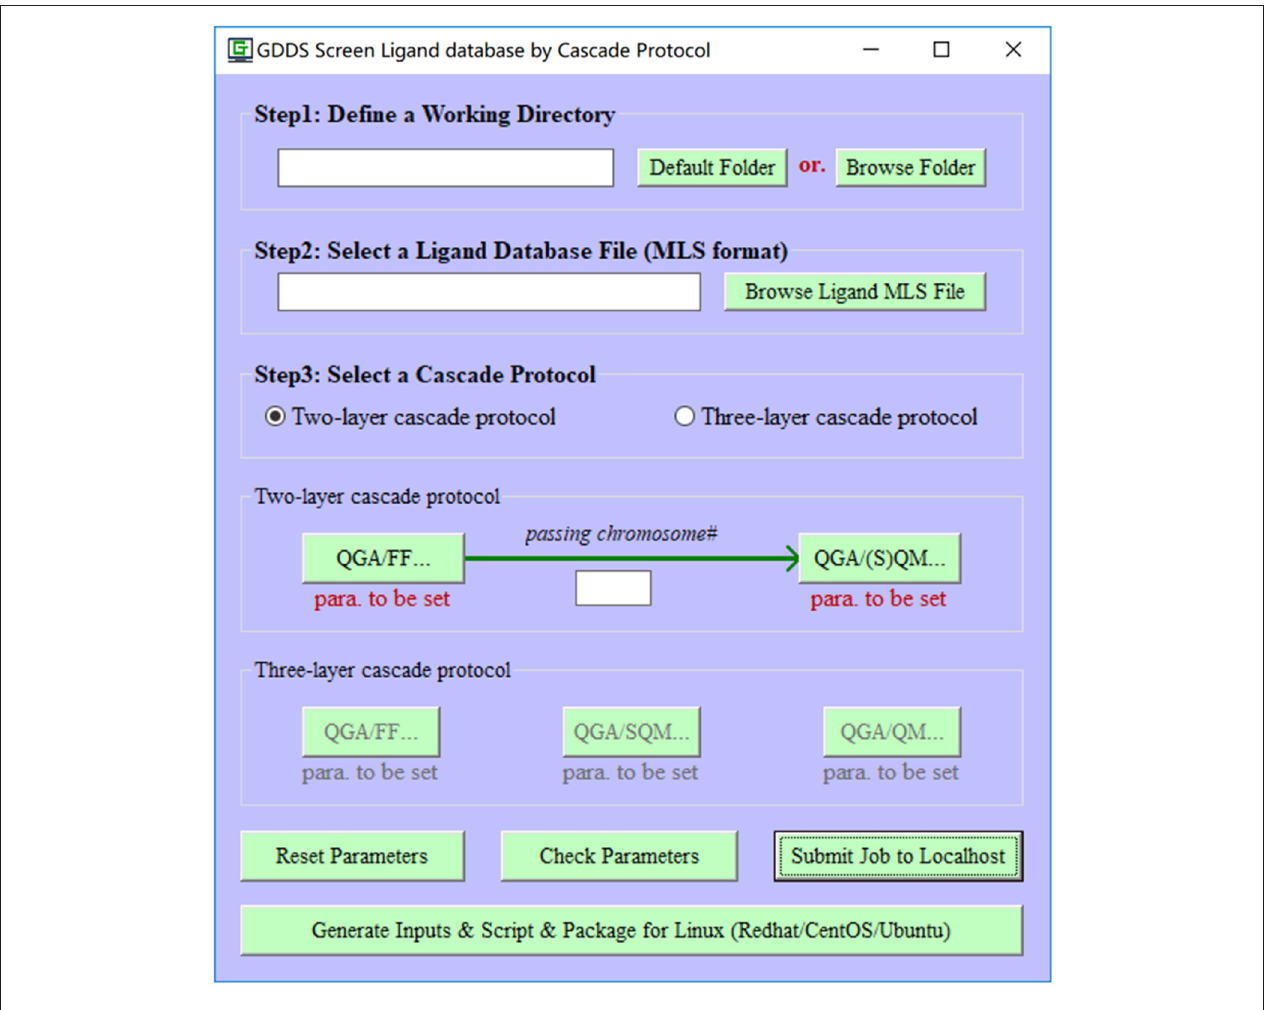
FIGURE 5 | A two-/three-layer cascade protocol implemented in